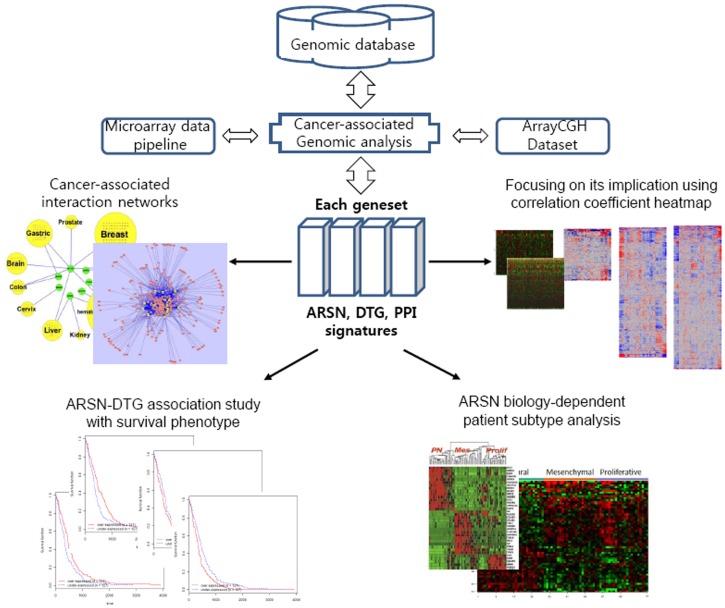
Outline of analysis procedures with each geneset showing the general steps required to identify genes that modulate a specific phenotype: selection of genes with the desired phenotype, and identification of phenotype-inducing ARSN and corresponding cancer-associated druggable target genes.